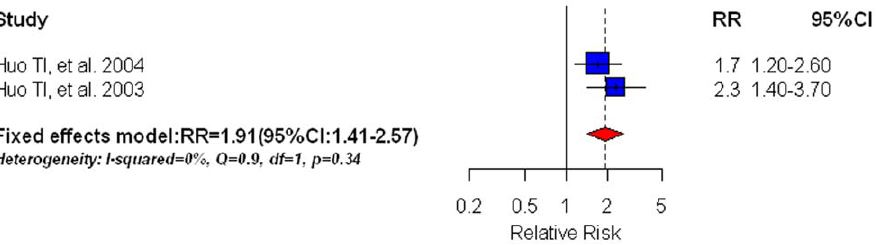
Figure 6. Summary estimate of relative risk (RR) for hepatic decomposition (HD) occurrence in HCC patients with pre-existing diabetes mellitus in comparison with non-diabetic patients. Squares represent study-specific estimates (size of the square reflects the study- specific statistical weight, i.e. inverse of the variance); horizontal lines represent 95% CIs; diamonds represent summary estimates with corresponding 95% CIs.